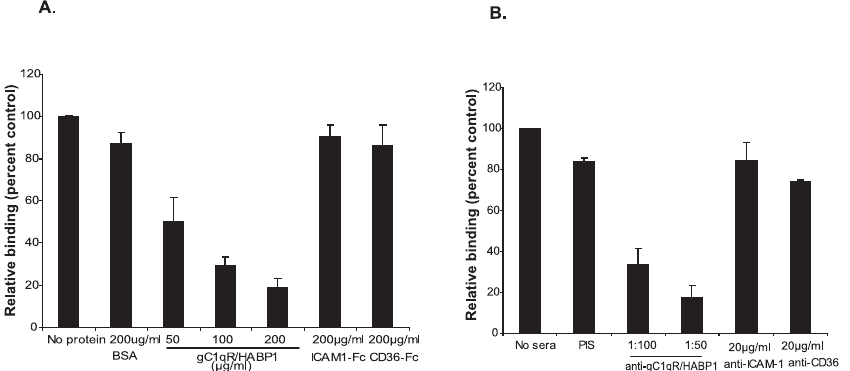
Figure 2. Inhibition of IRBCs Binding to HBMECs with Soluble gC1qR/HABP1 and Mouse Antiserum against